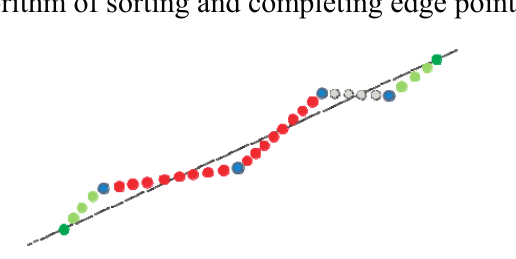
Figure 7. Algorithm of sorting and completing edge points, Method 1.